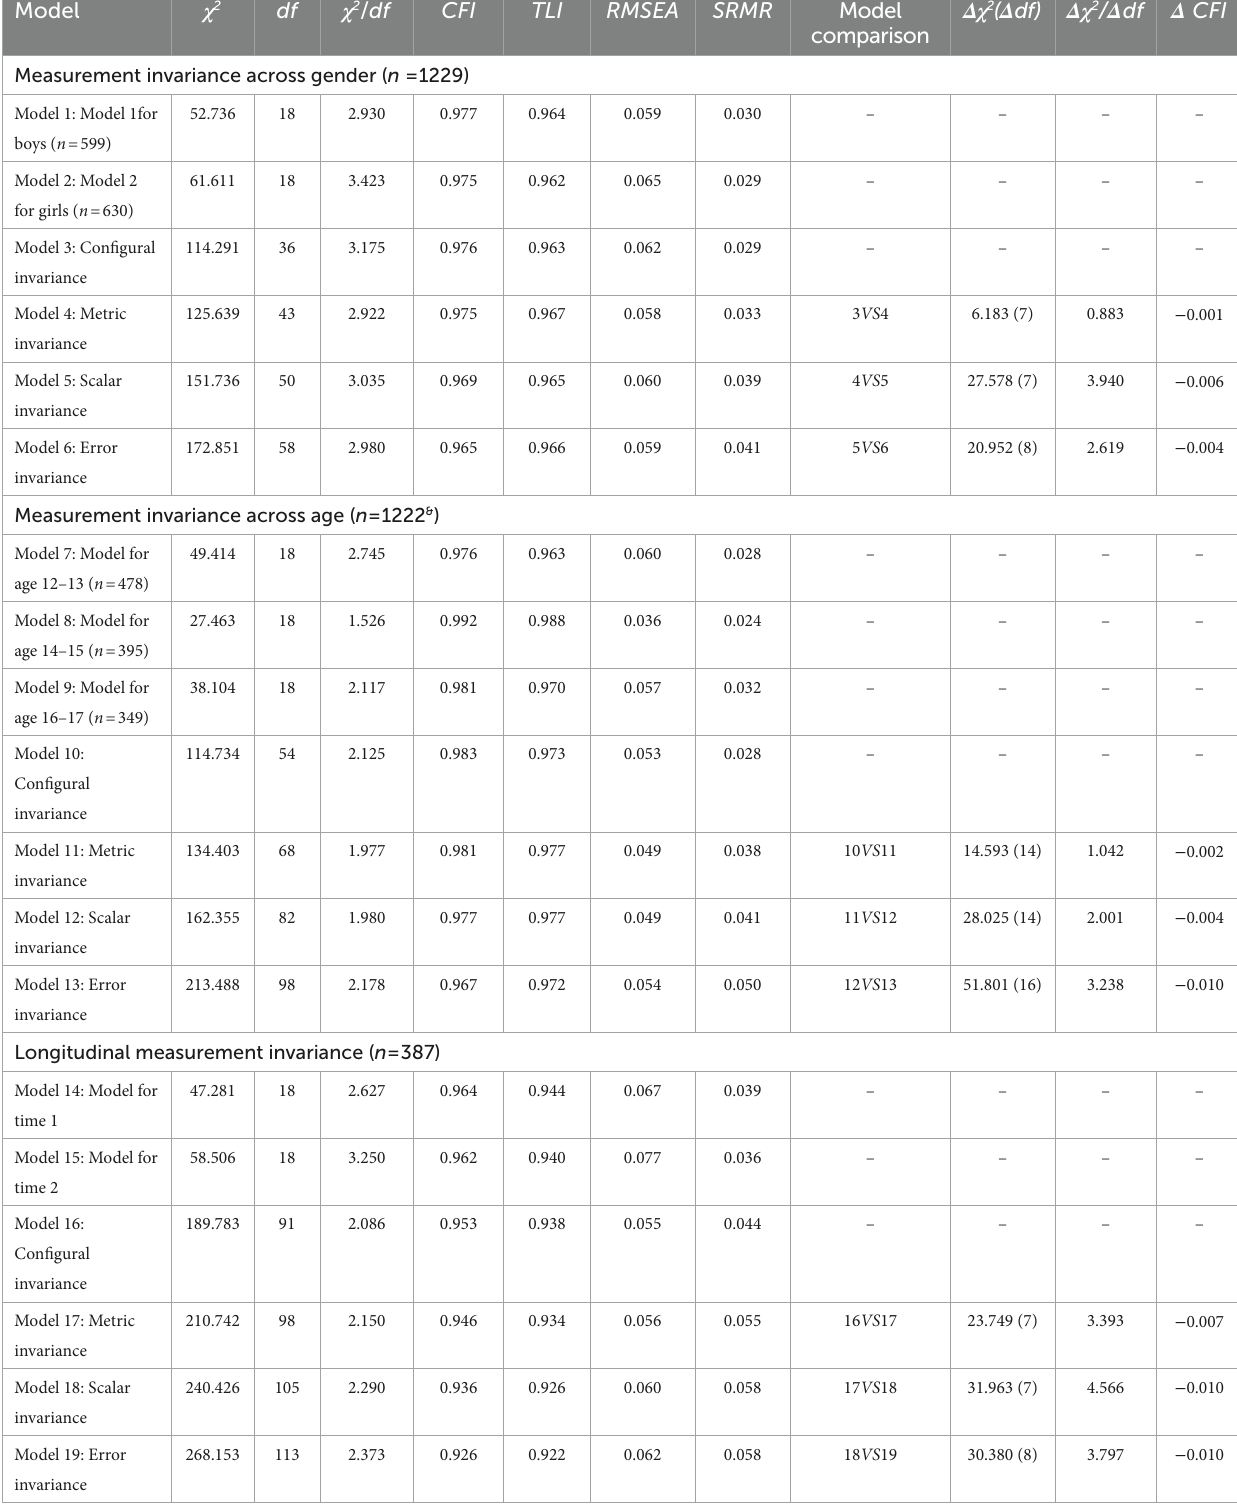
TABLE 1 Measurement invariance of the PSWQ-A across gender, age and times.